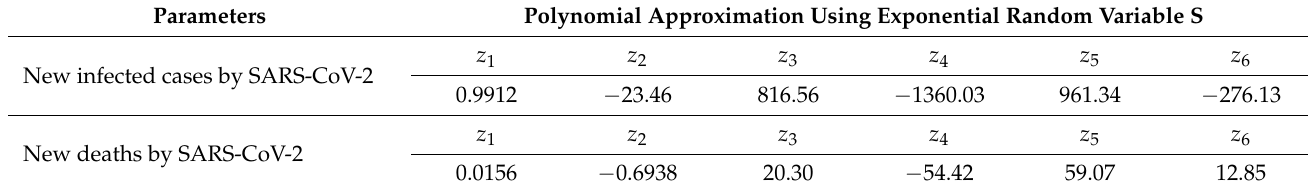
Table 7. Estimation of Polynomial function of key parameters of SARS-CoV-2 using COL.